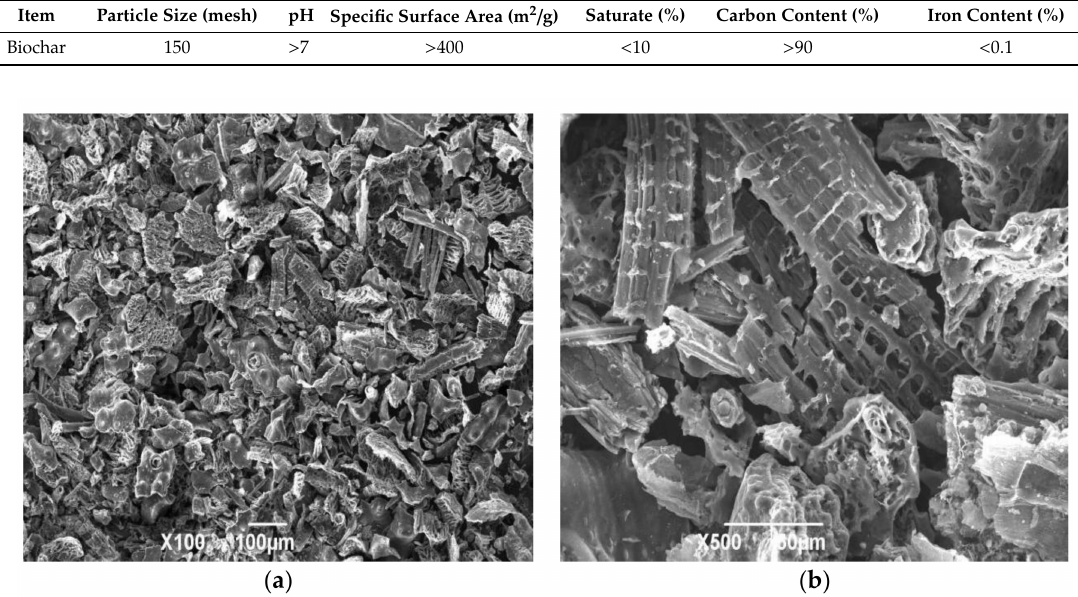
Table 2. Biochar technical parameters.